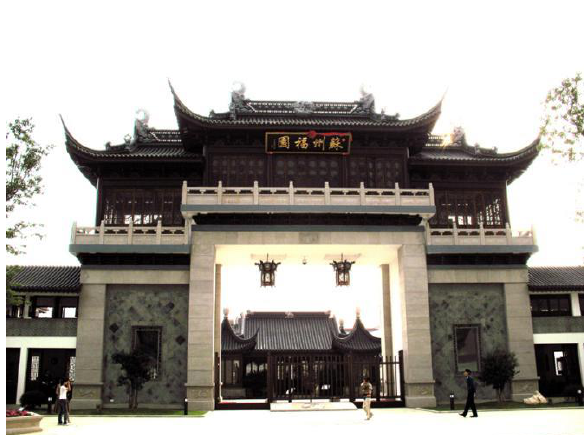
Figure 18. Suzhou Fuyuan courtyard garden villa estate gate in its vernacular architectural style. Photo: Donia Zhang 2007.